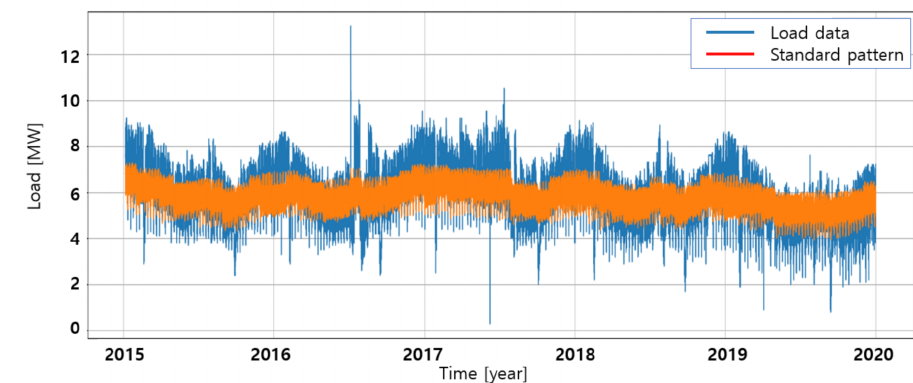
Figure 7. Example of the annual standard pattern and the actual load data.